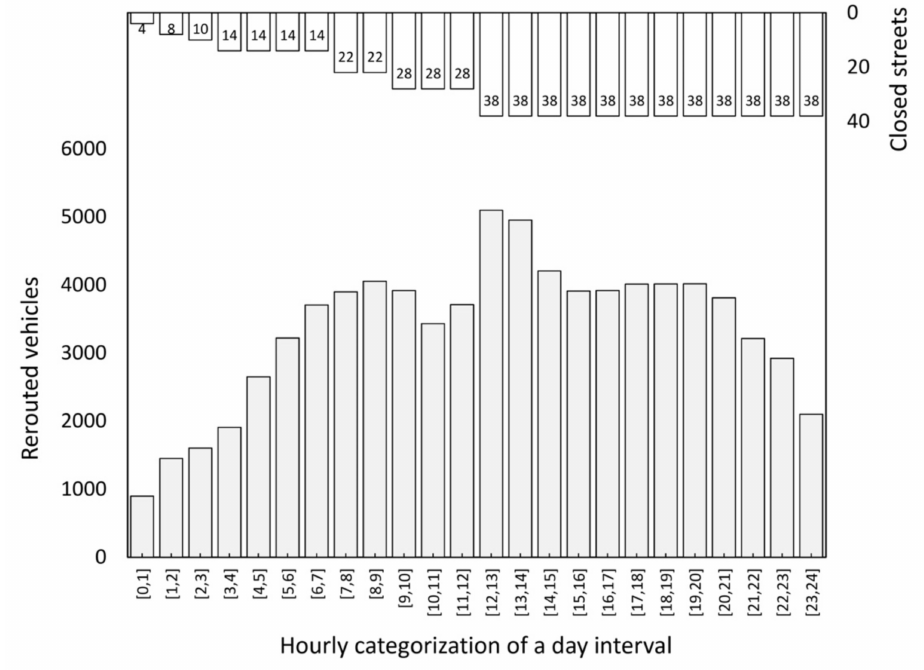
Figure 6. Rerouted vehicles and closed streets during the one-day